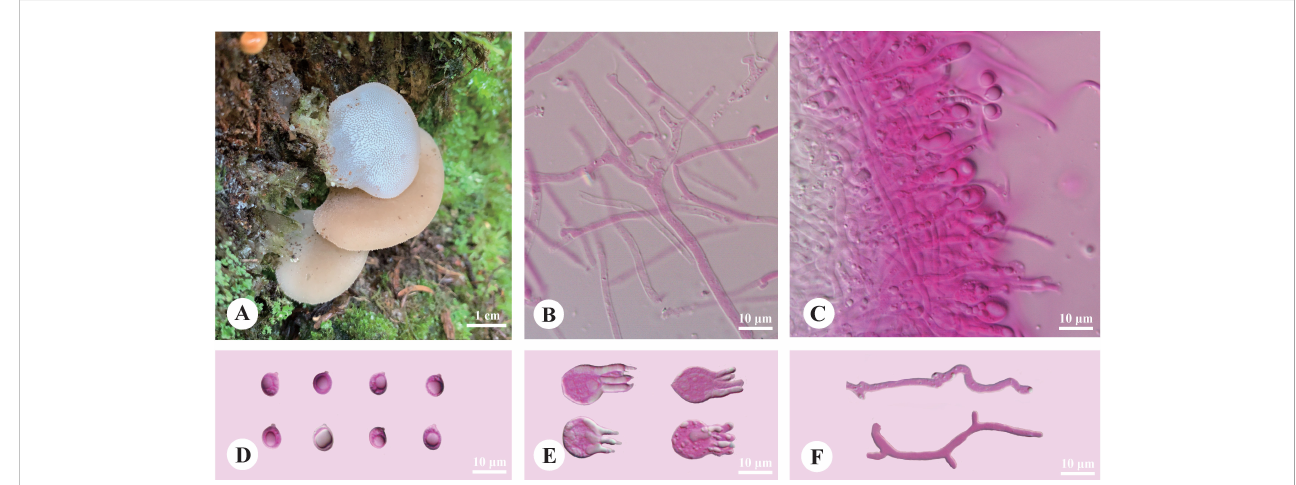
FIGURE 2 Basidiomata and microscopic structures of Pseudohydnum abietinum (holotype, Dai 24185). (A) Basidiomata; (B) Tramal hyphae; (C) A section of hymenium; (D) Basidiospores; (E) Basidia; (F) Hyphidia.